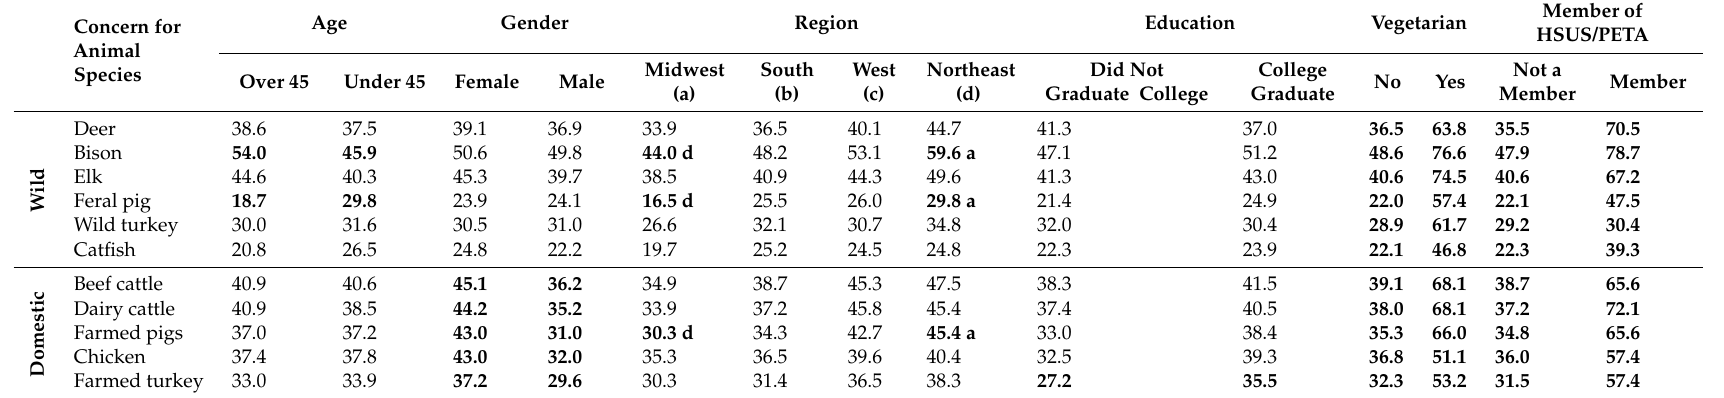
Table 6. Cross tabulations between demographics and concern for the welfare of wild and domestic